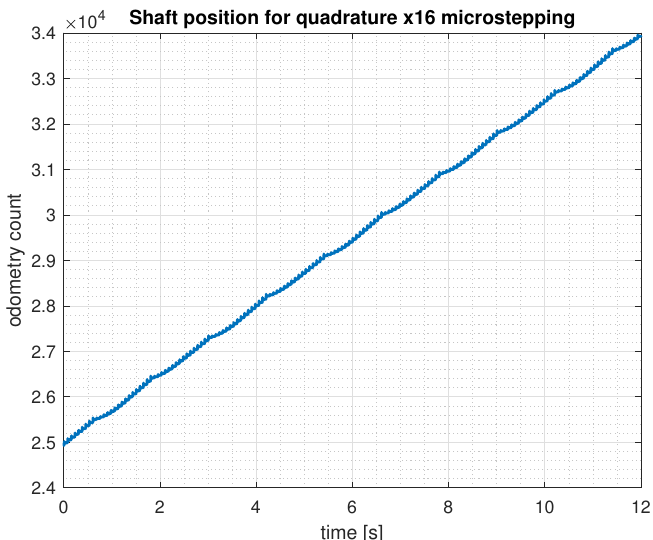
Figure 17. Presentation of a full collection of 12,000 data points sampled at 1 kHz. Odometry count is the raw position data obtained from the incremental encoder. The motor was working under the load in the quadrature x16 mode.